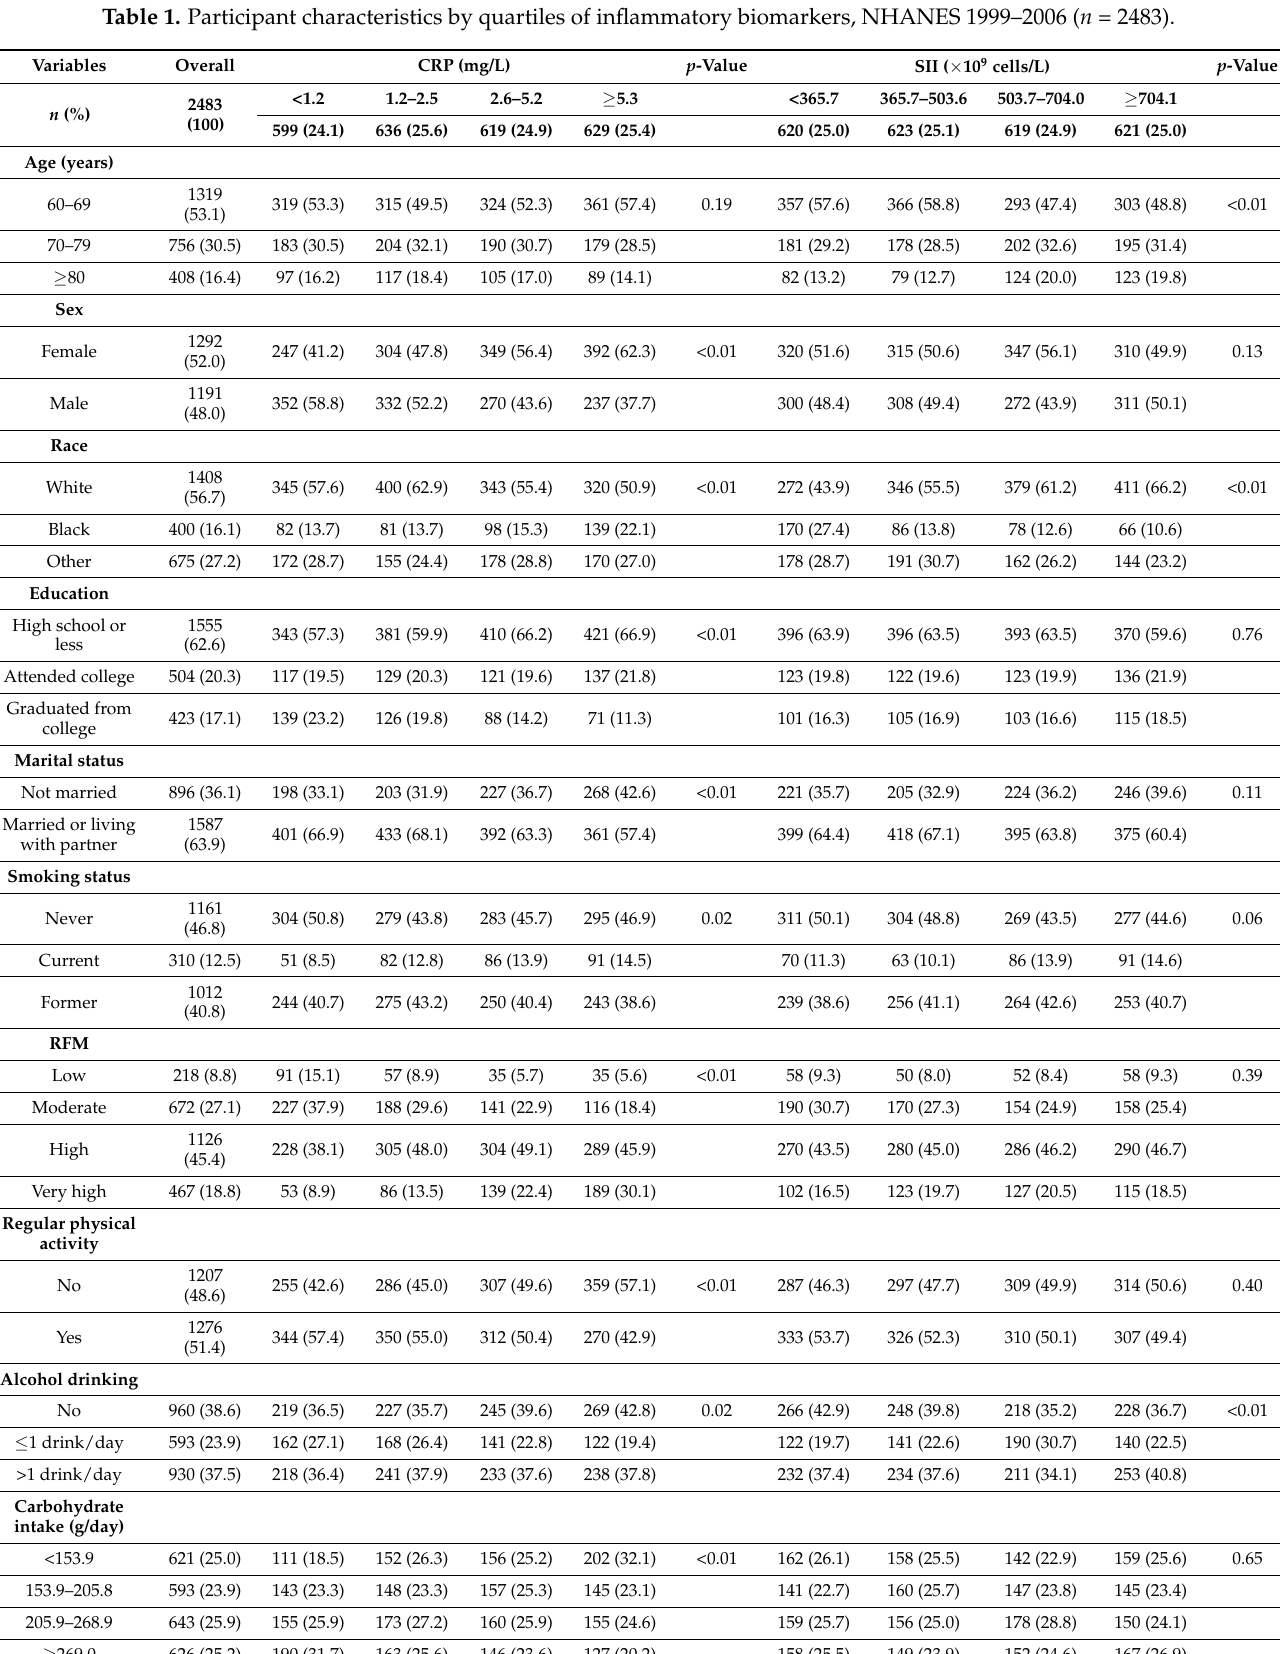
Table 1. Participant characteristics by quartiles of inflammatory biomarkers, NHANES 1999–2006 ( n =